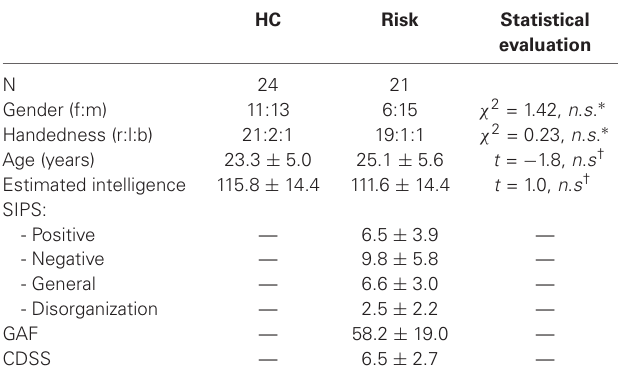
Table 1 | Demographic characteristics and symptom ratings .